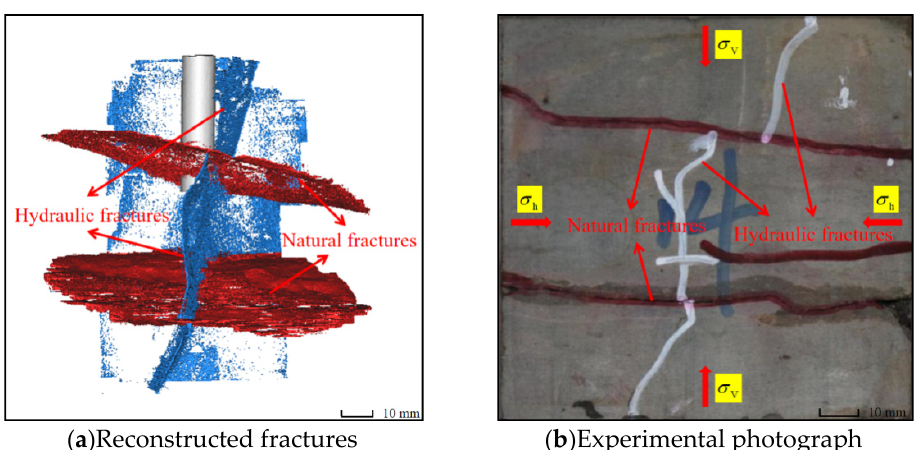
Figure 3. Three-dimensional (3D) reconstructed fractures and experimental photograph of sample H5.